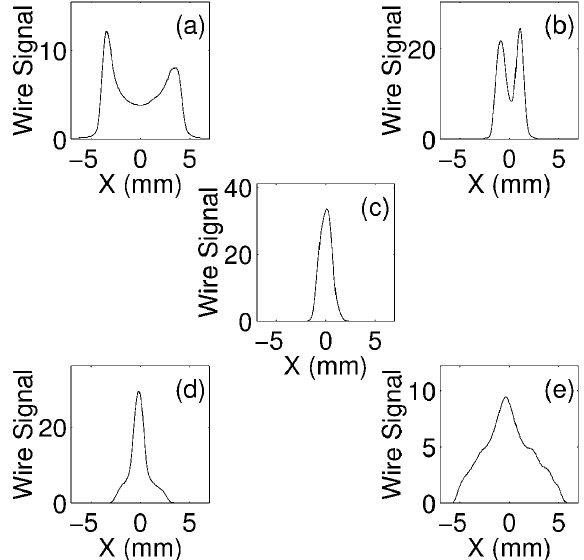
FIG. 6. Experimental sampling wire measurements at five values of the solenoid current, adjusted to sample the profile at the s positions in Fig.